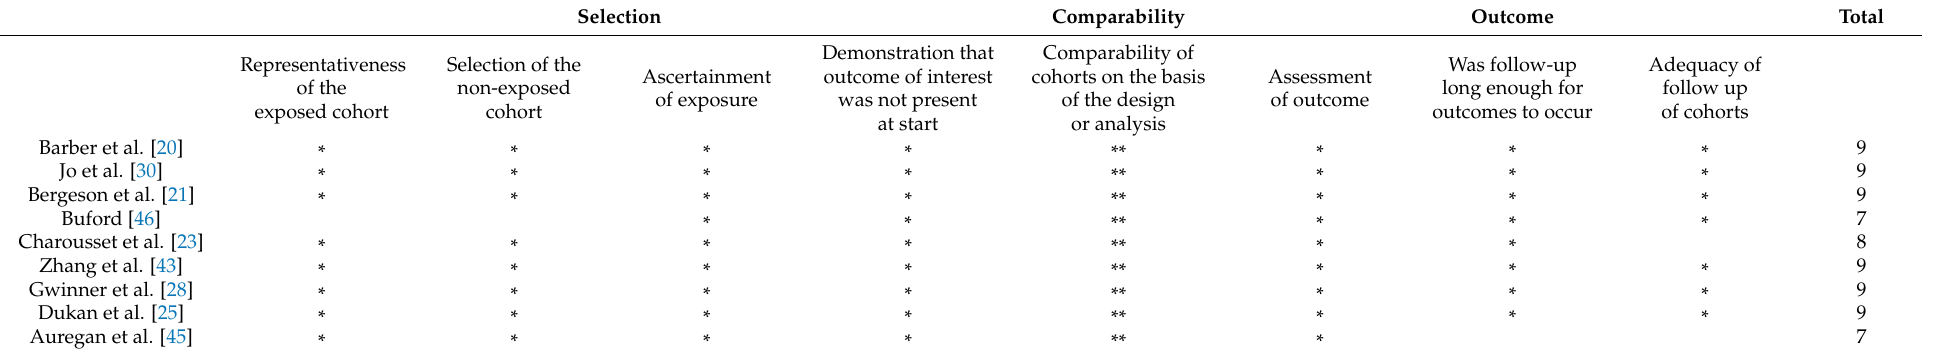
Table 2. Assessment of non-randomized studies according to the Newcastle–Ottawa quality assessment scale for cohort studies. Selection Comparability Outcome Total Representativeness Selection of the of the non-exposed exposed cohort cohort